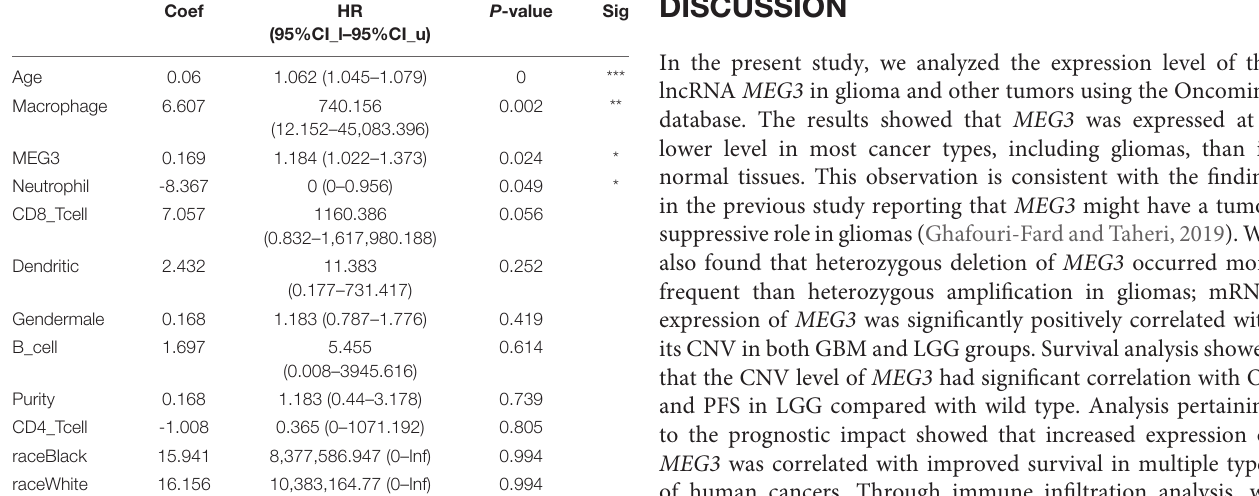
TABLE 3 | Multivariate analysis of the correlation of MEG3 expression and immune infiltrates with OS in LGG. Coef